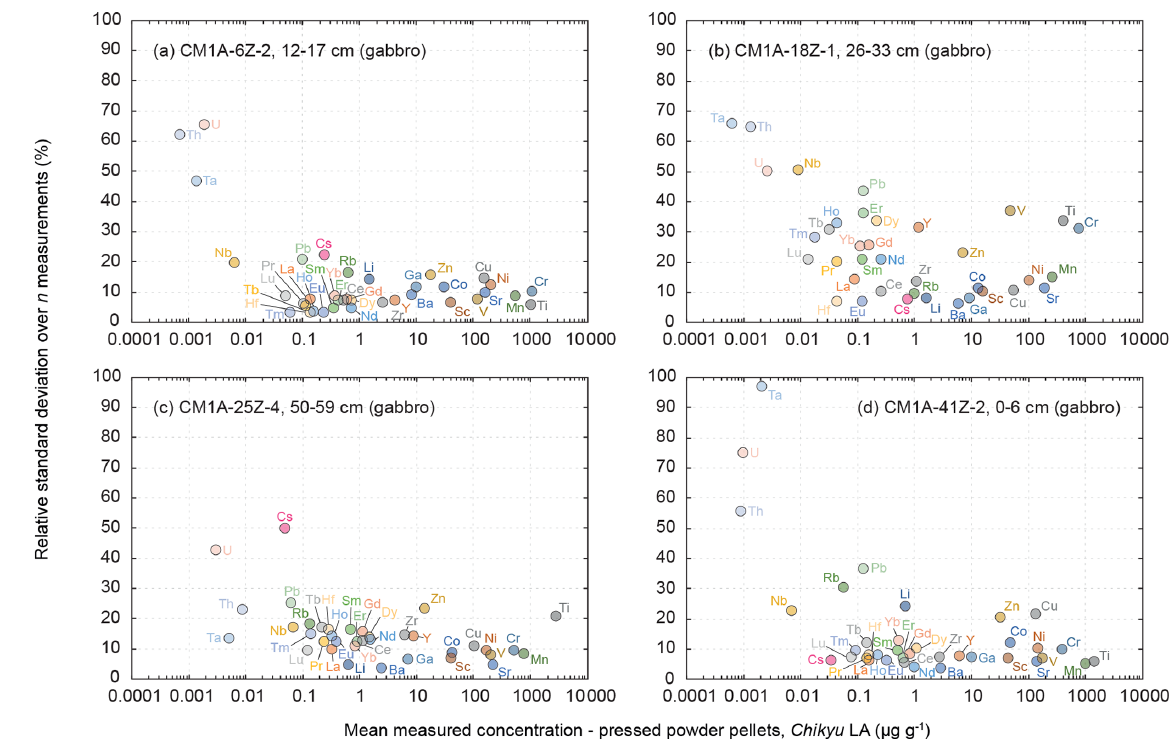
Figure 7. Evolution of the relative standard deviation (RSD, in %) relative to the measured element concentrations for the four gabbro samples from the Hole CM1A (a) CM1A-6Z-2, 12–17cm ( n = 5), (b) CM1A-18Z-1, 26–33cm ( n = 5), (c) CM1A-25Z-4, 50–59cm ( n = 6), and (d) CM1A-41Z-2, 0–6cm ( n =